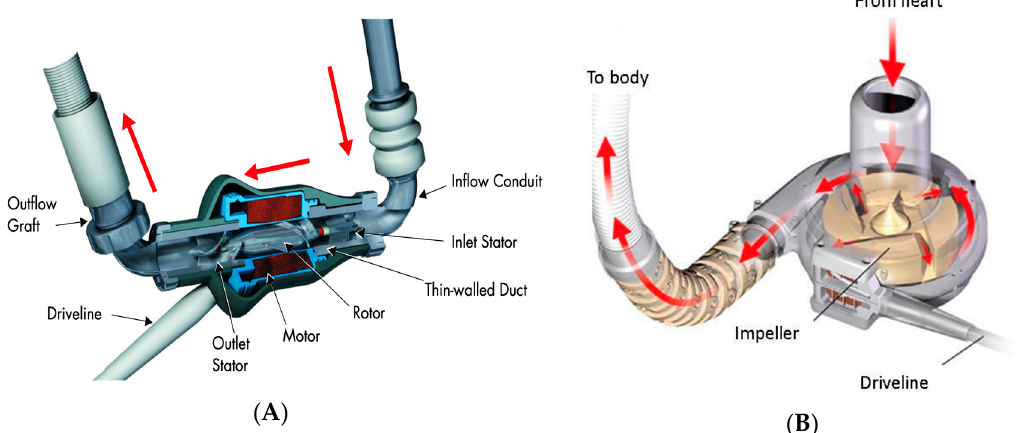
Figure 2. Pump housing and impeller design. ( A ): (left) Axial flow pump: HeartMate II LVAD (taken from Figure 2 in the HeartMate II left ventricular assist system instructions for use). ( B ) (right) Centrifugal flow pump: HeartWare assist device (taken from Figure 2 in the HeartWare assist device patient manual).